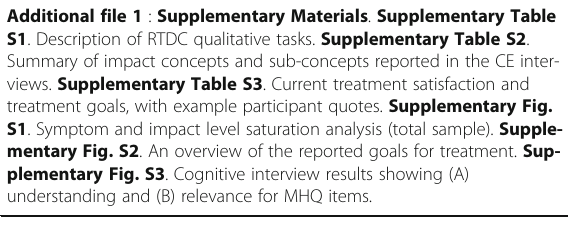
Additional file 1 : Supplementary Materials . Supplementary Table S1 . Description of RTDC qualitative tasks. Supplementary Table S2 . Summary of impact concepts and sub-concepts reported in the CE inter- views. Supplementary Table S3 . Current treatment satisfaction and treatment goals, with example participant quotes. Supplementary Fig. S1 . Symptom and impact level saturation analysis (total sample). Supple- mentary Fig. S2 . An overview of the reported goals for treatment. Sup- plementary Fig. S3 . Cognitive interview results showing (A) understanding and (B) relevance for MHQ